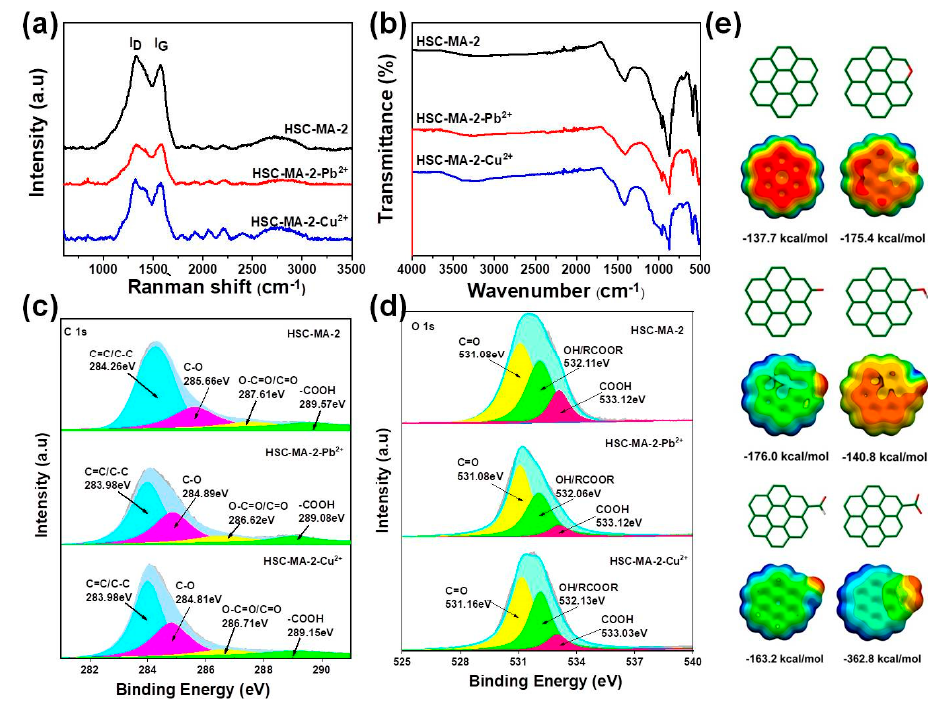
Figure 11. Raman ( a ), FTIR ( b ) spectra, high-resolution C1s ( c ) and O1s ( d ) spectra of HSC-MA-2 before and after Pb 2+ and Cu 2+ adsorption, ( e ) Gauss simulation on the Pb 2+ binding energies with different types of oxygen functional groups on the carbon domain.